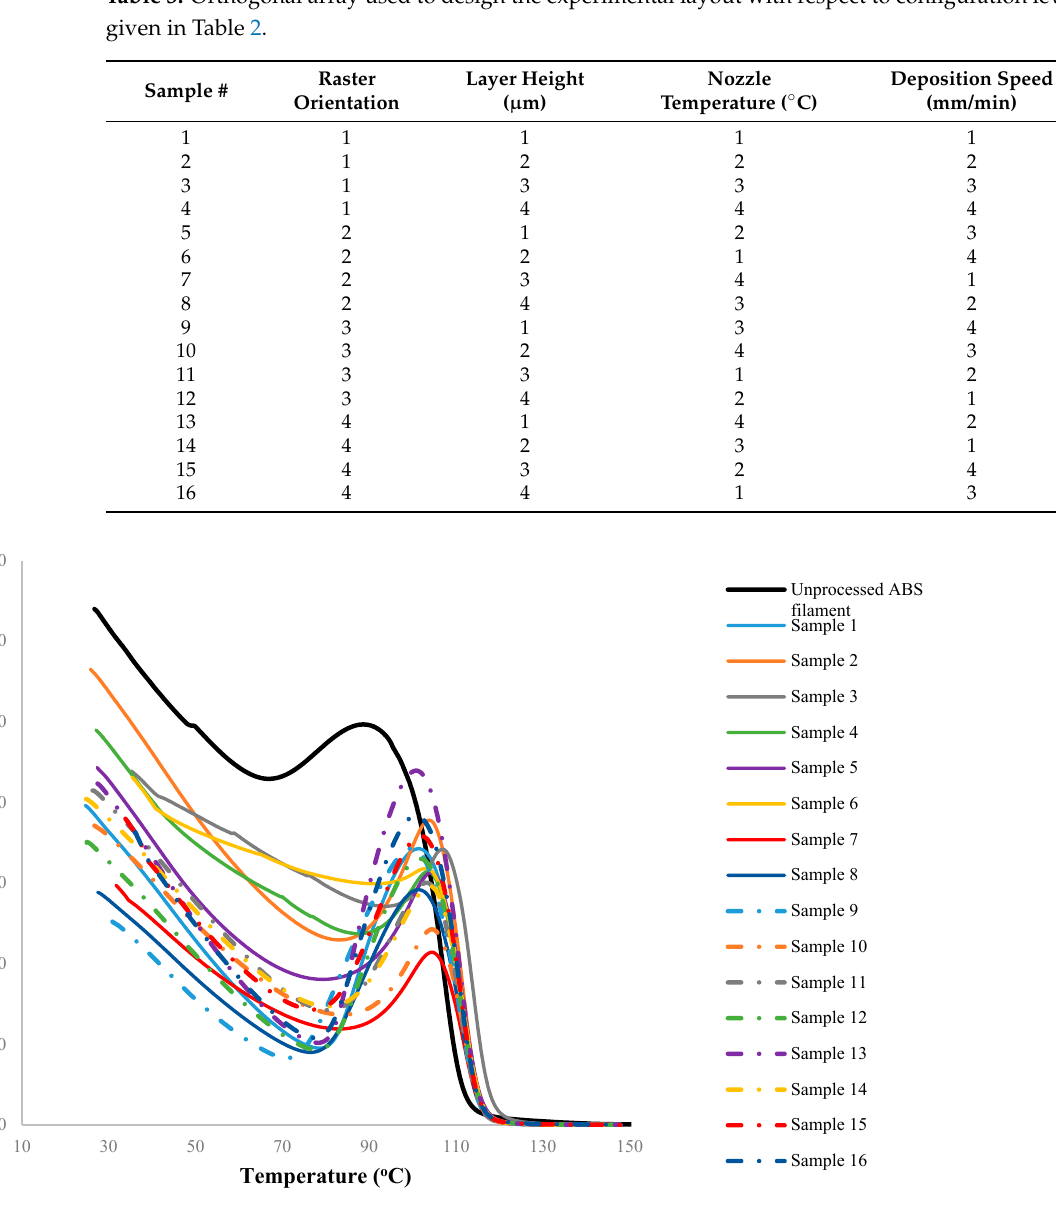
Table 3. Orthogonal array used to design the experimental layout with respect to configuration levels given in Table 2.